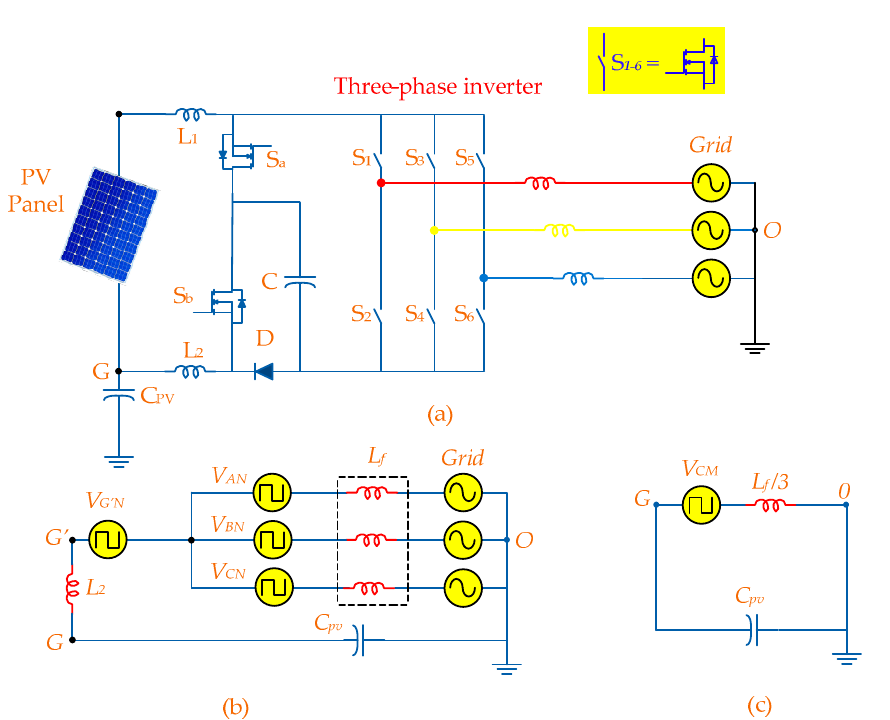
Figure 17. ( a ) Two switched quasi-switched boost inverter; ( b ) Equivalent model of the common- mode model of modified 2 Switch-qSBI topology; ( c ) Simplified model of the common-mode model of modified 2 Switch-qSBI.